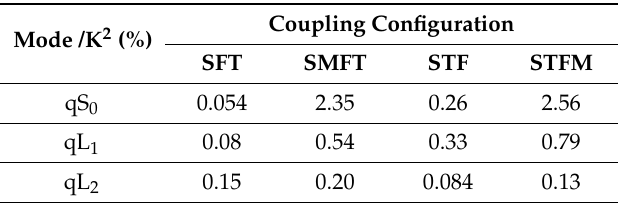
Table 1. The K 2 of the qS 0 , qL 1 , and qL 2 modes travelling in the a-SiC (5 µm)/ZnO (2.5 µm) plate, for λ = 50, 16.7, and 8.8 µm.